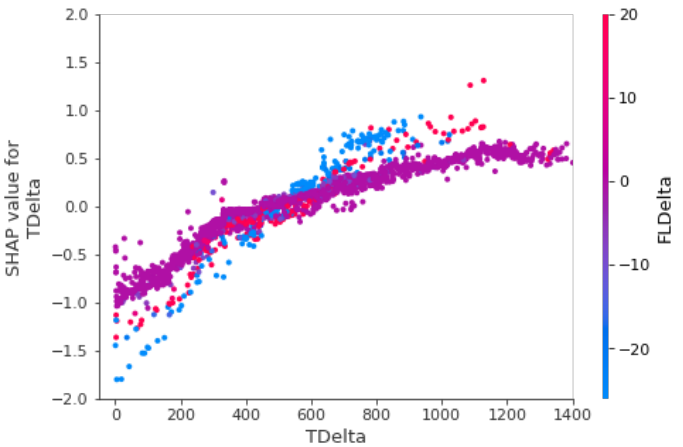
Figure 10. SHAP values (regression) of TDelta according to FLDelta for Sector 2.